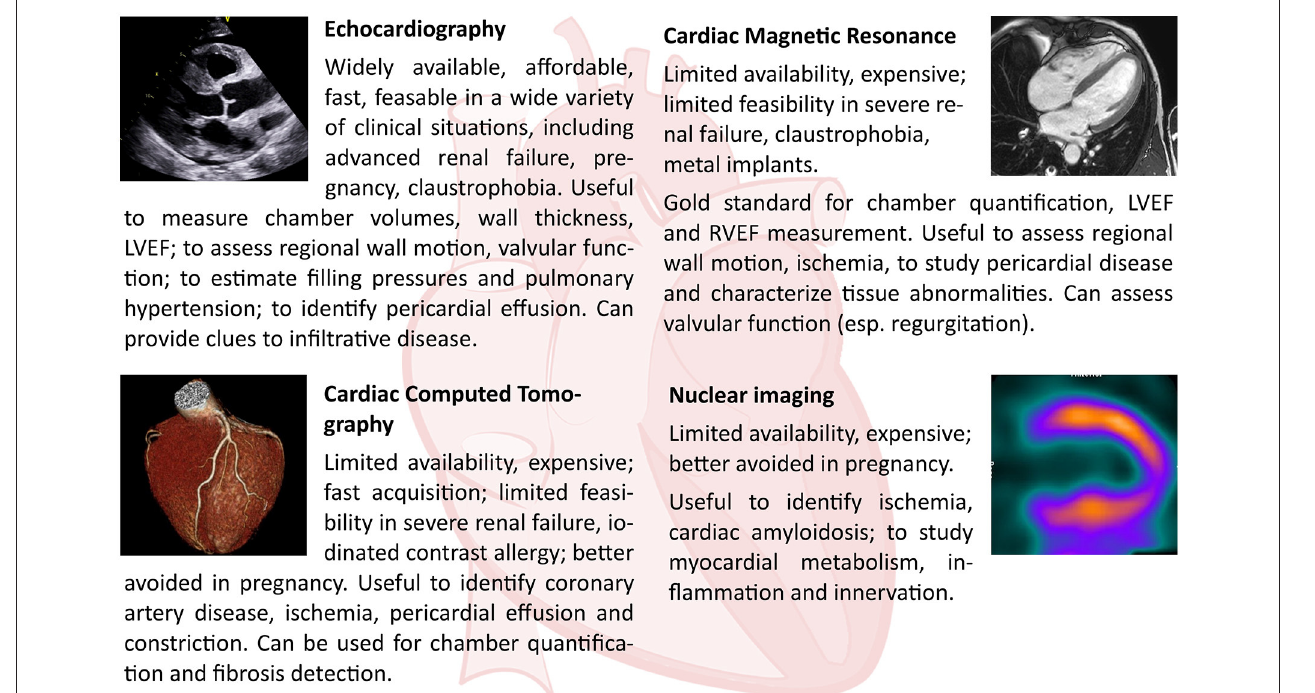
FIGURE 2 | Strengths and limits of each cardiac imaging modality, and their principal applications in the diagnosis of